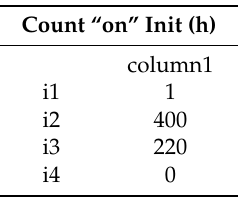
Table A7. Time that unit i has been up before t = 0 (h): count_on_init( i ).